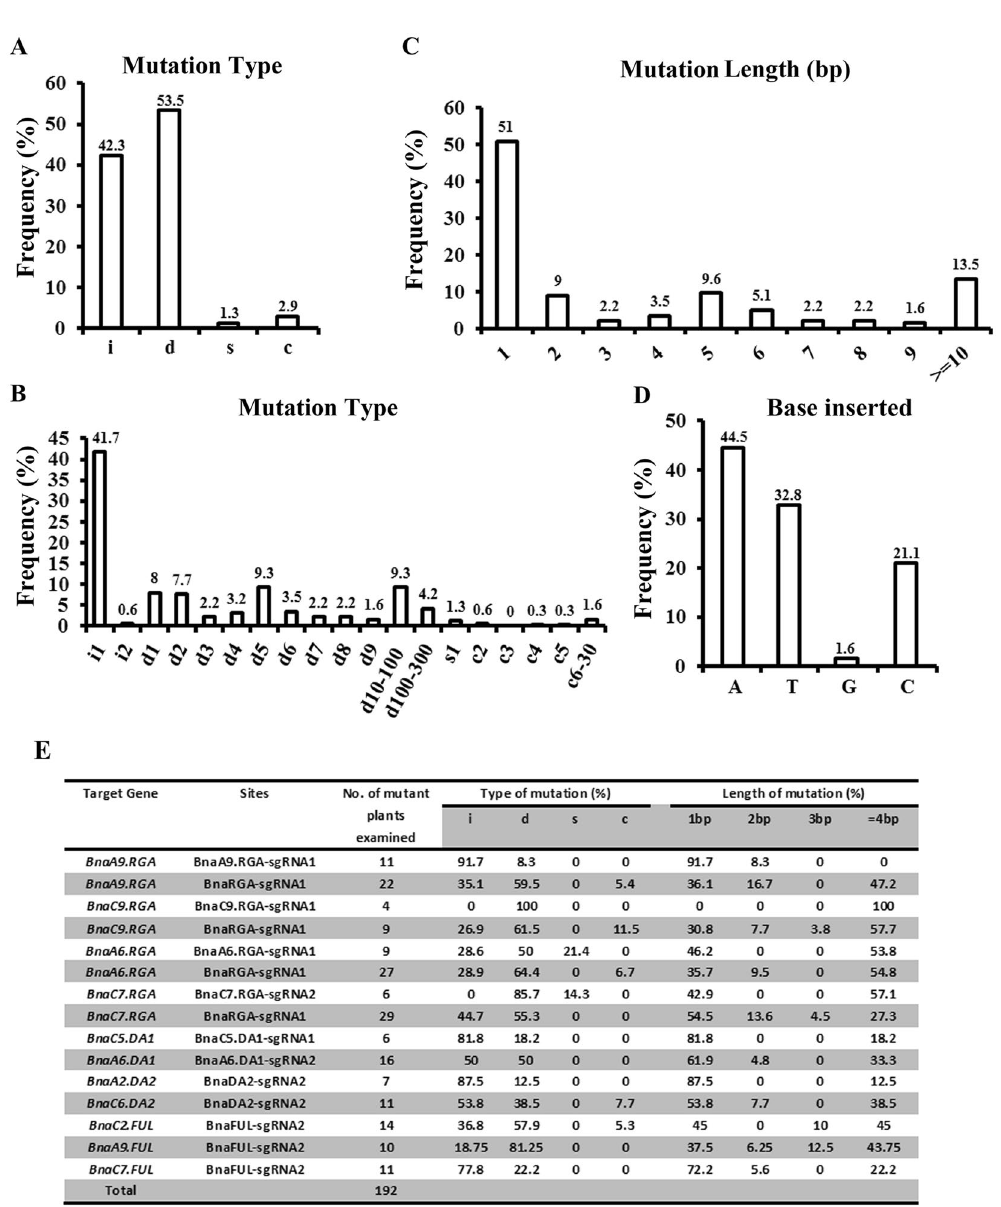
new mutations in shoots and flower buds (Supplemental Tables S3 and S4), indicating that the wild type alleles from these plants were further mutated by CRISPR/Cas9. When 3 bp or multiples of 3 bp are deleted from an exon without affecting the reading frame, a few amino acids may be deleted from the middle of a protein, which may alter its biochemical properties. BnaA6 . RGA encodes a DELLA protein that negatively regulates GA signaling in many plant species. It is reported that deletion of the conserved TVHYNP domain resulted in a dwarf phenotype and insensitivity to exogenous GA 36,37 . Among the transgenic lines of BnaA6 . RGA-sgRNA , two T0 lines (T0-L4 and T0-L6) were dwarf (Fig. 3A), and the pheno- type was inherited in the T1 generation (Supplemental Fig. S10). According to the sequencing results, the T0-L4 and T0-L6 plants have a 6- and 12-nt deletion at the target sites, respectively (Fig. 3B, Supplemental Table S3), that causes a 2- and 4- amino acid deletion in the TVHYNP domain (Fig. 3C).